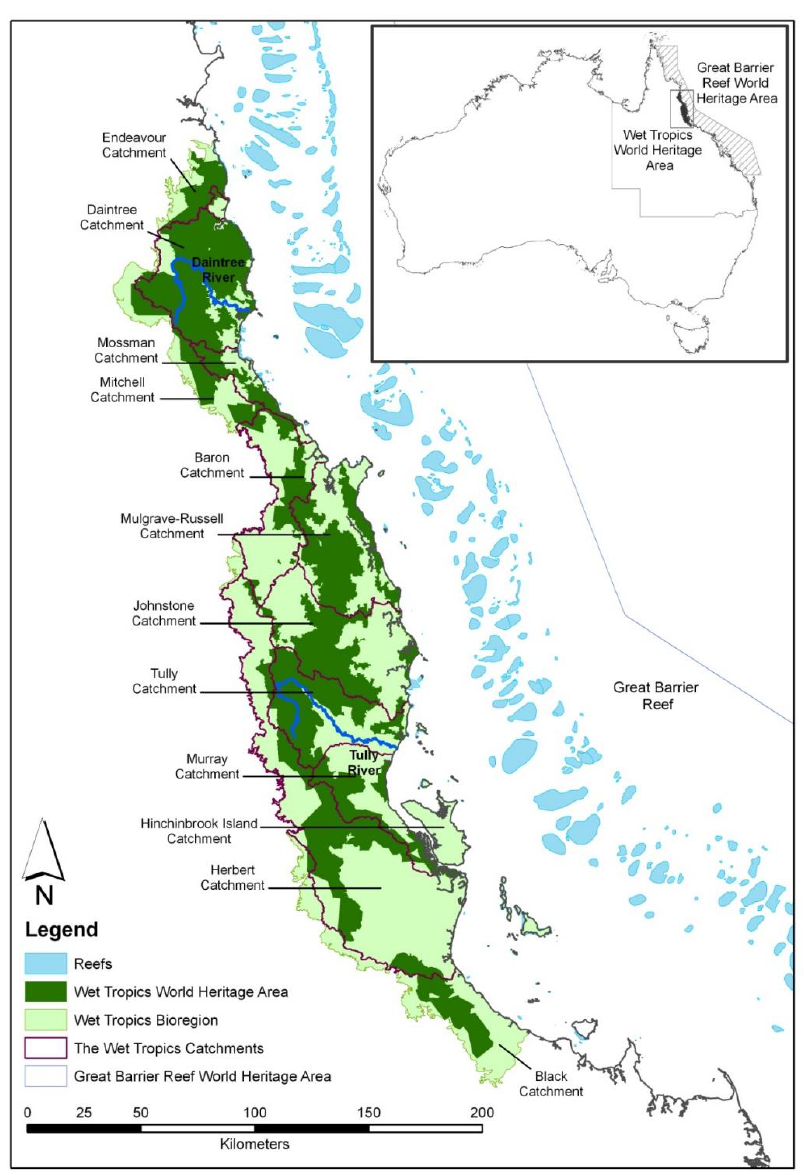
Figure 1. Location of the Tully Basin in Queensland, Australia [18].